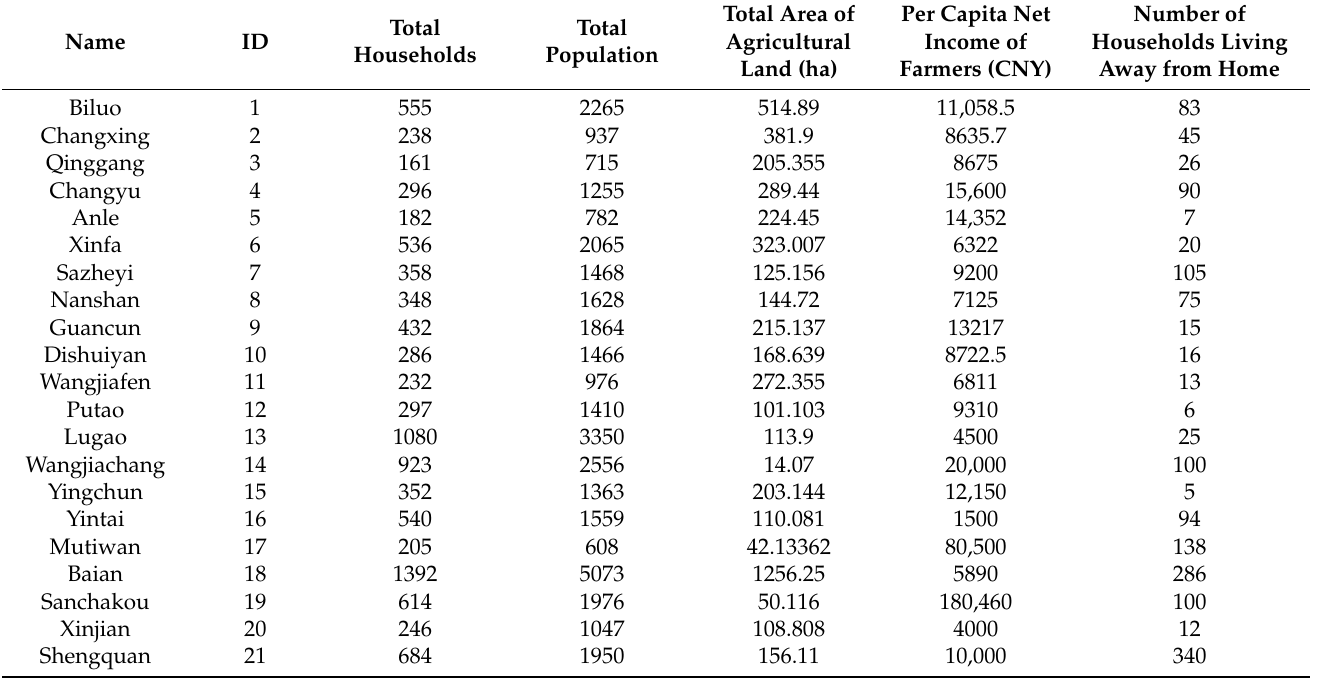
Figure 1. Location map of sample villages. Table 1. The detail information of the sample villages .